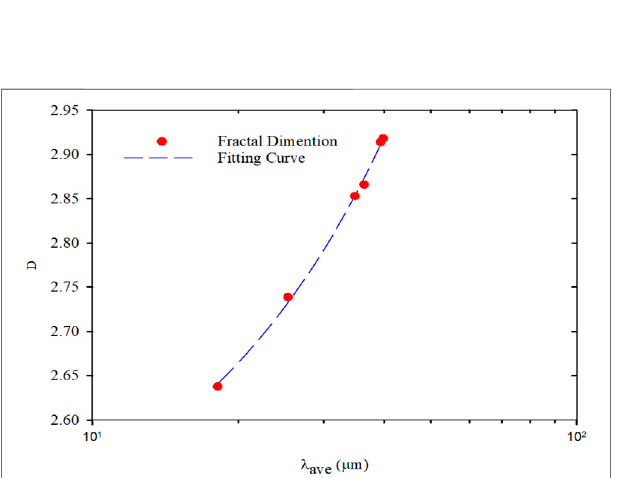
FIGURE 9 | Fractal dimension versus the average size of PMs.